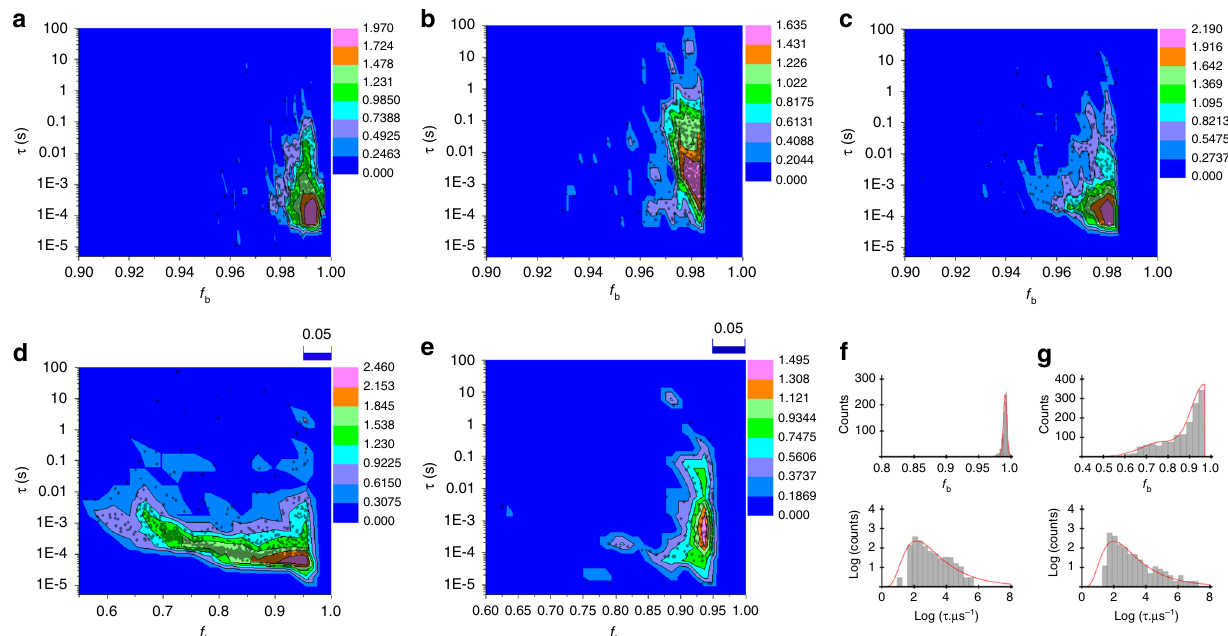
Fig. 3 Heat maps with superimposed scatter plots of alginate-induced events. Event counts (plotted as log 10 on the color axis) of a 4 µ L 0.2% (w/v) A1 using a ~19 nm diameter pore (~0.321 events·s − 1 ), b 20 µ L of 3% (w/v) A2 using a ~21 nm (~0.046 events·s − 1 ) and c 20 µ L of 10-minute enzyme digested 3% (w/v) A2 using a ~22 nm diameter pore (~0.112 events·s − 1 ), all in pH ~7 buffered 1 M KCl. The experiment in a was repeated d using a ~5 nm nanopore (~0.403 events·s − 1 ), and e an ~18 nm-diameter pore, but in 0.1 M KCl (vs. 1 M KCl in a ) electrolyte buffered at pH ~7 (~0.0527 events·s − 1 ). The plots in f and g show histograms of the data (the red lines show fi ts to the data) in a and d , respectively, with additional plots in Supplementary Fig. 4. The applied voltage difference was − 200 mV for all measurements